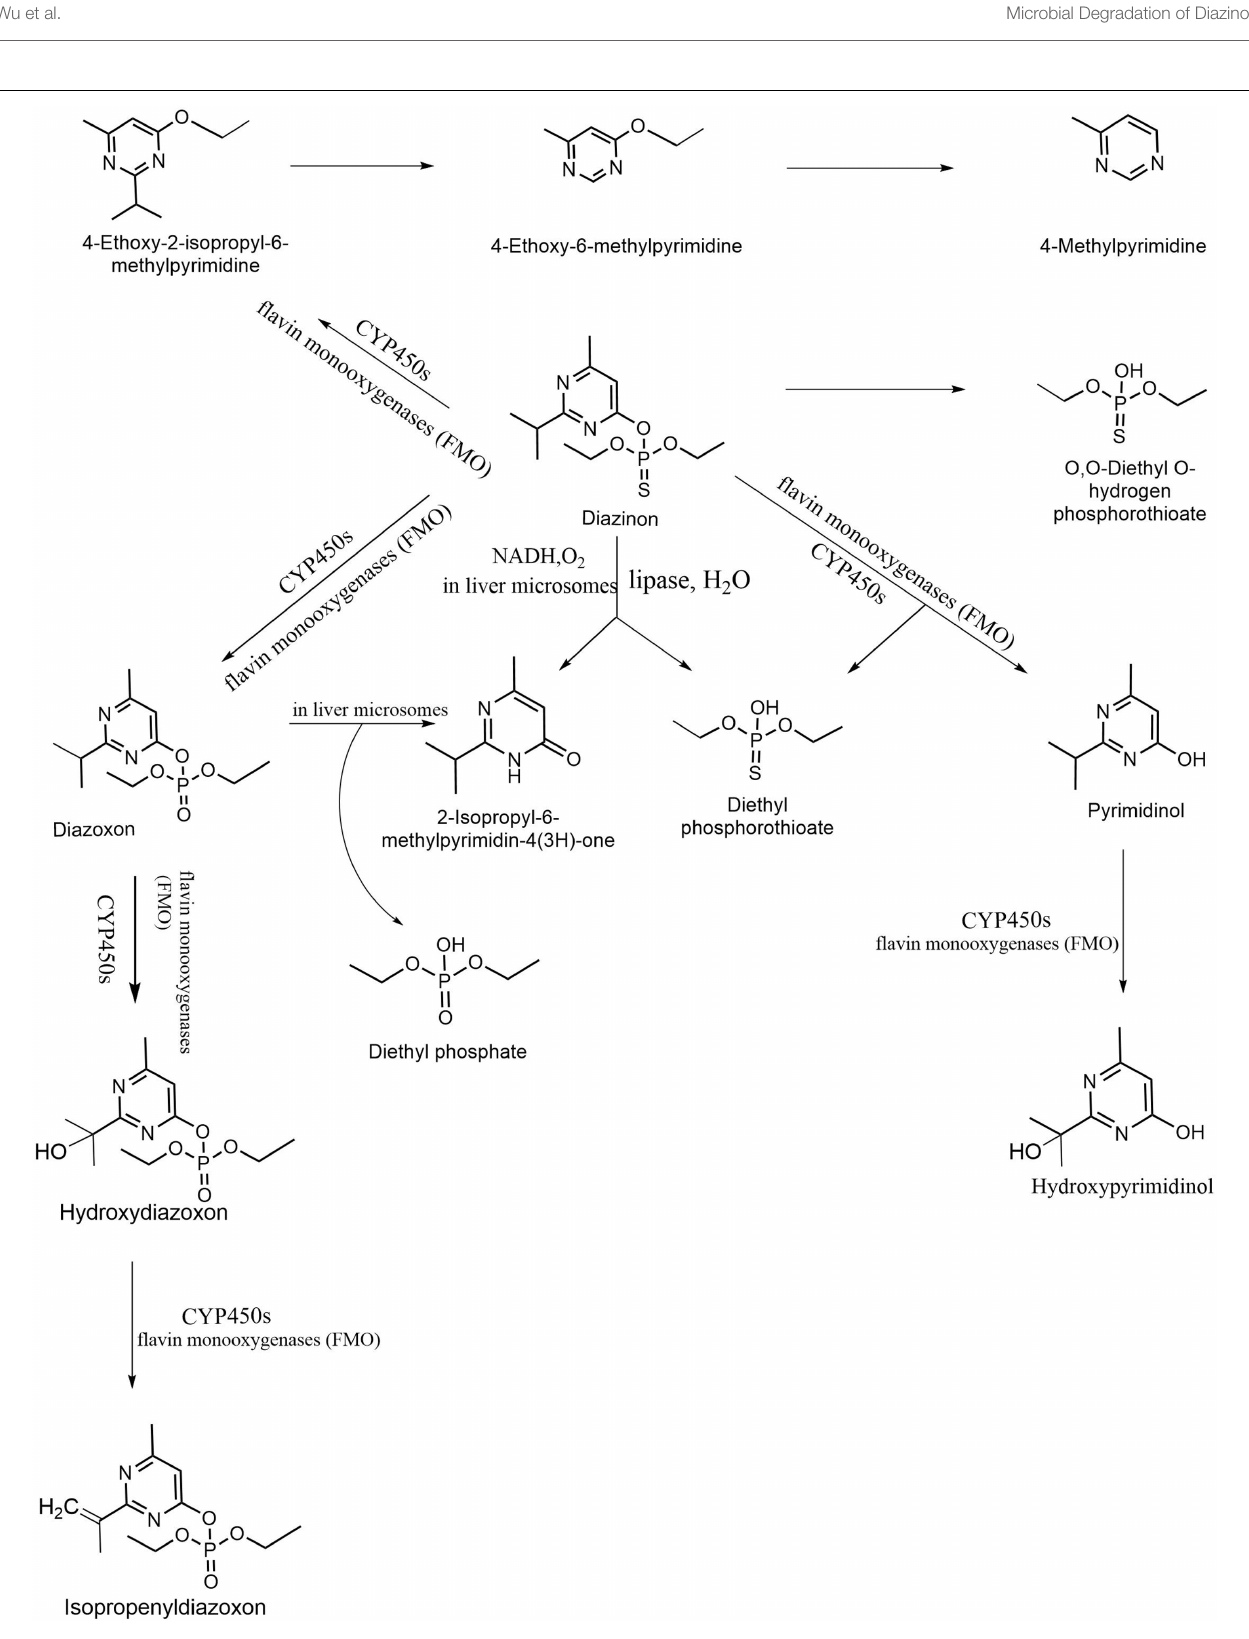
Frontiers in Microbiology |